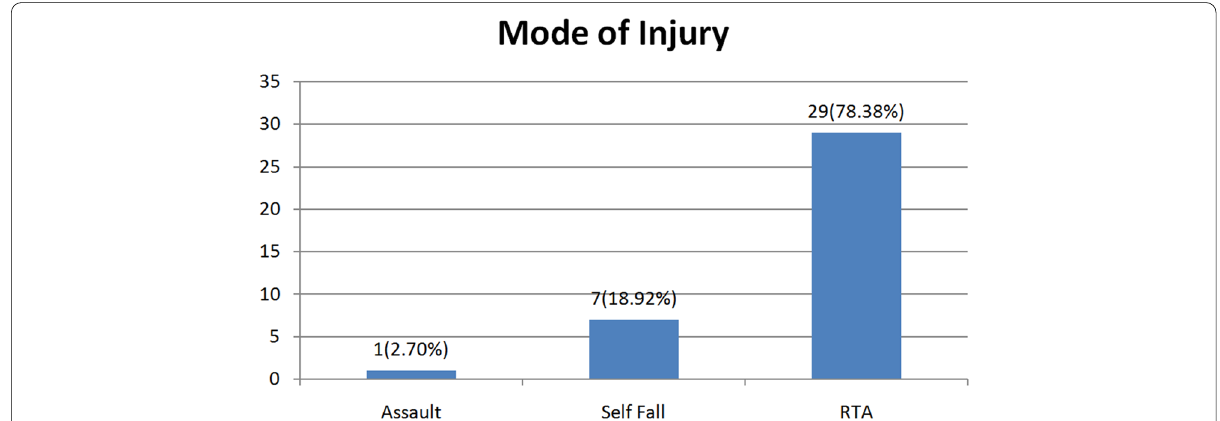
Fig. 2 The distribution according to the mode of injury